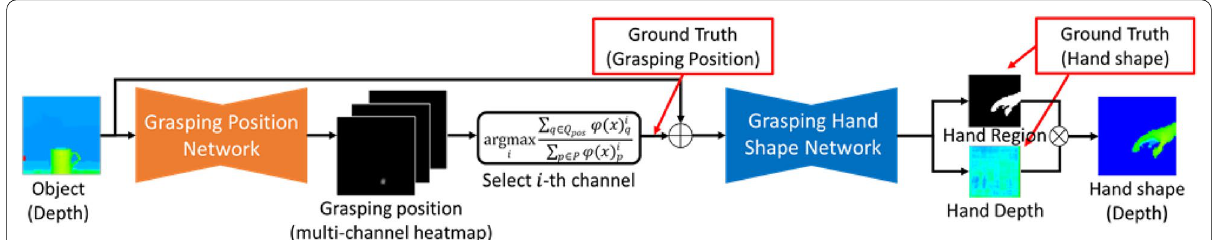
Fig. 2 The learning flow of the grasping position network and the grasping hand shape